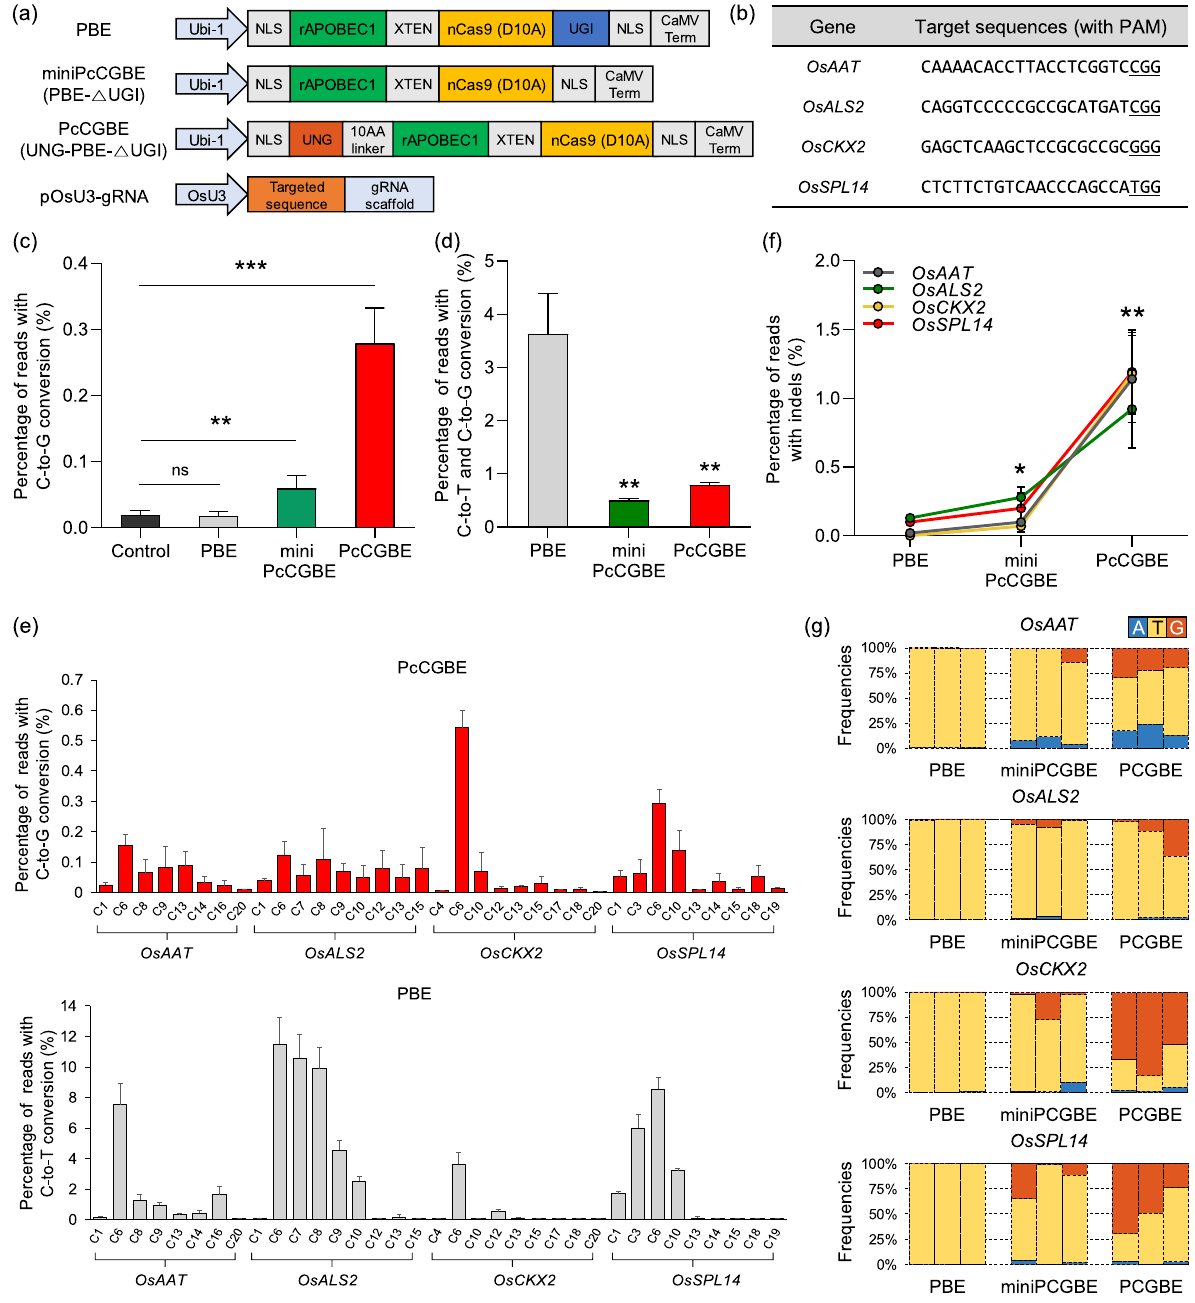
Fig. 1 Evaluation of C‑to‑G base editing in rice protoplasts. a Construction of C‑to‑G base editors. XTEN, a 16‑aa linker; UGI, uracil glycosylase inhibitor; UNG, E. coli uracil glycosylase. b Target sequences. c Average C‑to‑G base editing efficiencies at C6 positions of four targets. Control, PEG‑treated protoplasts. The p values were determined by two‑tailed Student’s t‑test. ns, not significant ( p > 0.05); ** p < 0.01, *** p < 0.001. d Frequencies of C‑to‑T and ‑G conversions at OsCKX2 . e Frequencies of C‑to‑G or ‑T conversions using PcCGBE and PBE at all cytosines in four targets. f Indel frequencies in four targets. g Three replicas of C‑to‑D ratios at C6 positions of four targets. In (c), (d), (e), and (f), Values are the mean SEM. In ± (d) and (f), statistical differences were tested using one‑way ANOVA analysis (n 3). * p < 0.05, ** p < 0.01, *** p < =